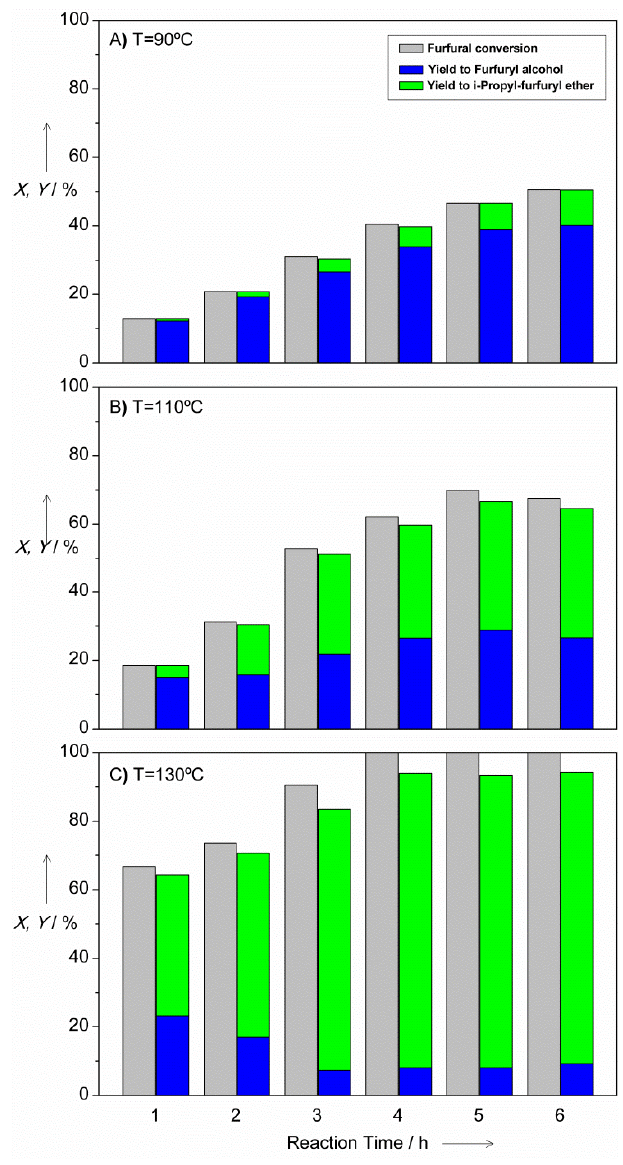
Figure 3. MPV reduction of furfural with i -PrOH in presence of Zr-SBA-15—Influence of the reaction temperature. Reaction Conditions: Catalyst loading: 0.2 g; i -PrOH to furfural molar ratio: 50; furfural to catalyst mass ratio: 1.0; X = Substrate conversion; Y = Product